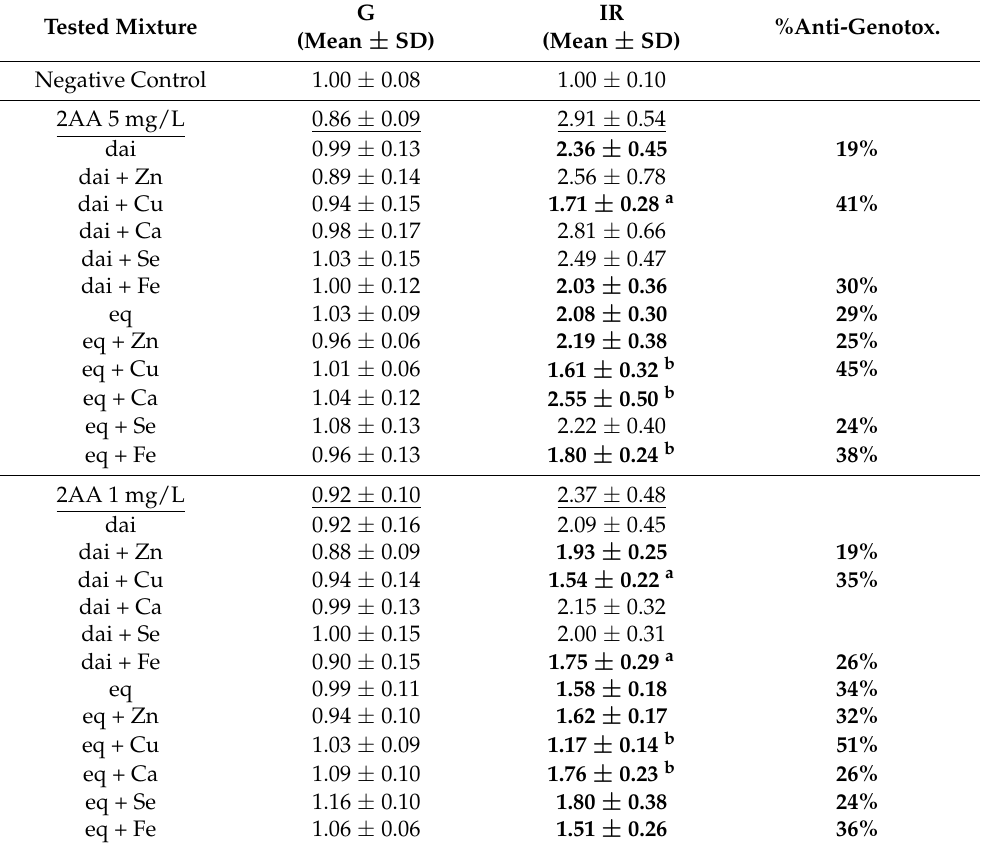
Table 6. Evaluation of anti-genotoxic activity based on G and IR values for the genotoxin–2AA (5 mg/L, 1 mg/L)—and the mixture of 2AA with daidzein, equol and the combinations with